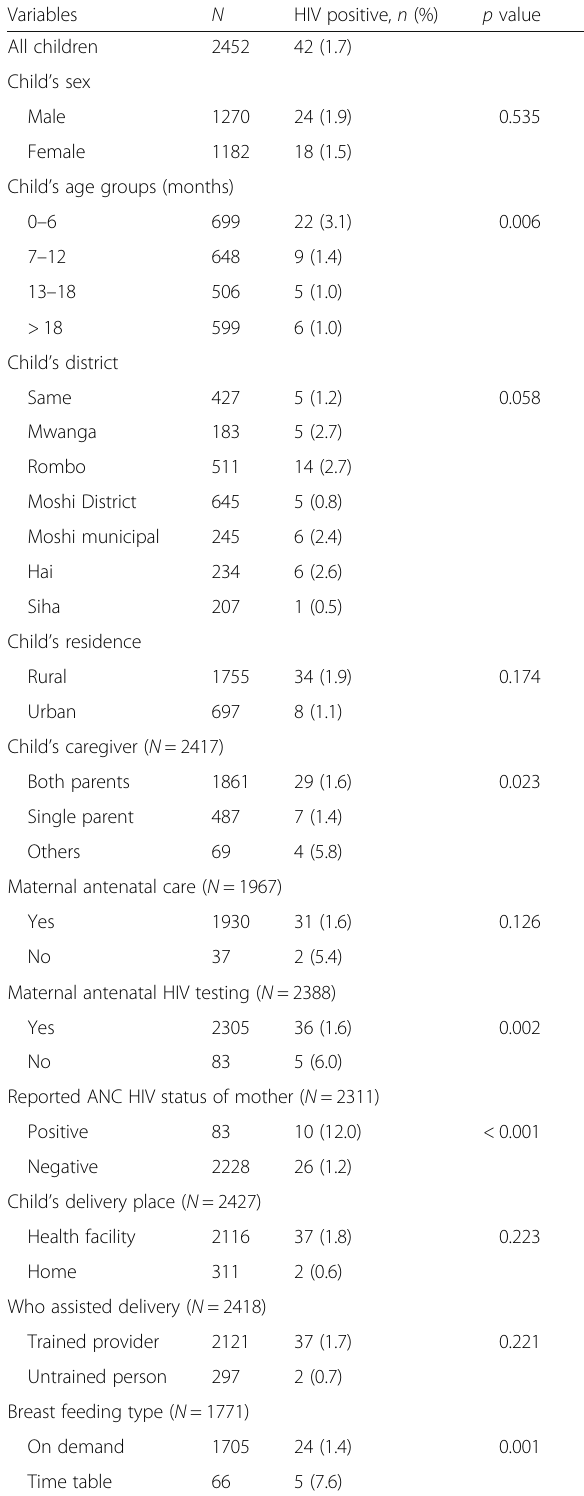
Table 2 Background characteristics by HIV-seropositive status among the 2452 children in Kilimanjaro